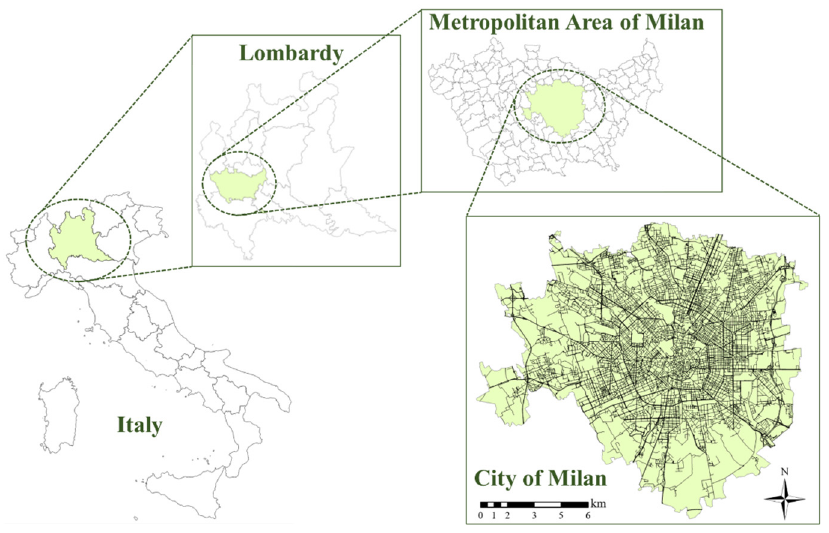
Figure 3. Location of the city of Milan in Italy.